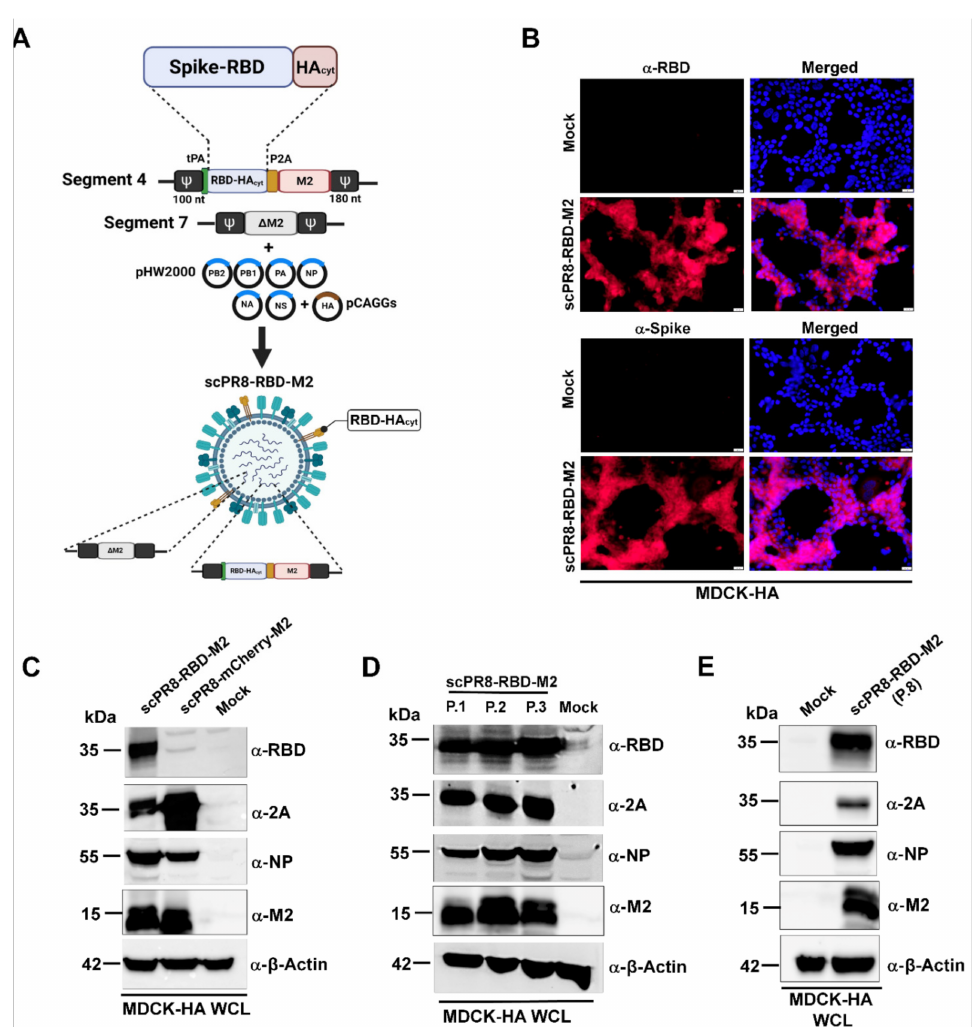
Figure 1. Generation and characterization of scPR8 containing receptor binding domain (RBD) of SARS-CoV-2 spike protein (scPR8-RBD-M2). ( A ) Schematic diagram of a reverse genetics-generated scPR8-RBD-M2. The chimeric gene cassette comprising tPA followed by a bicistronic RBD and M2 protein expression was introduced in the segment 4 (HA). The packaging signal sequence ( Ψ ) at both 3 (cid:48) and 5 (cid:48) terminal ends are also depicted. ( B ). scPR8-RBD-M2 infected MDCK-HA cells were assessed for RBD-HAcyt expression by (B)IFA using α -RBD and α -spike antibodies (scale bar indicates 100 µ m) and ( C ) Western blot using α -RBD, -2A, -NP and – β actin as primary antibodies. Lower band(s) in lane 2 detected by α -2A antibody possibly indicate partially degraded mCherry-2A protein. ( D ) Stability of RBD-M2 inserted in infected MDCK-HA cells after several passages and ( E ) at the 8th passage was determined by Western blot. Mock infected MDCK-HA cells were used as a control. WCL: whole cell